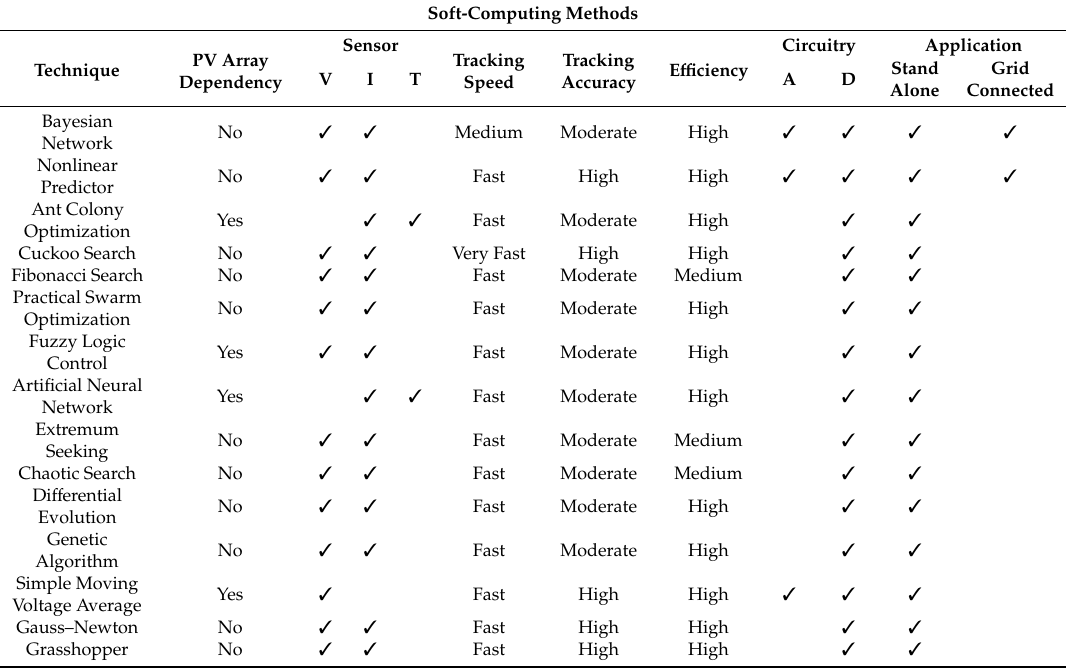
Table 3. Comparison of soft computing maximum power point techniques under non-uniform solar irradiance.